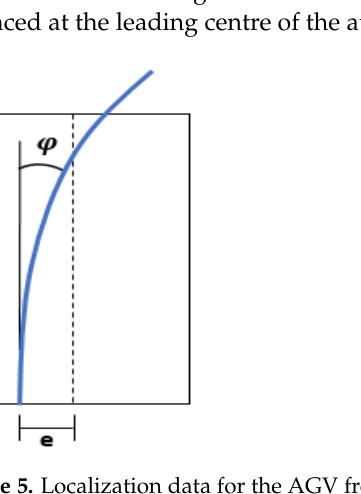
( b ) Figure 6. Path approach: ( a ) Situation where φ path is zero; ( b ) Situation where φ path is not zero. With this approach, it is possible to analyse the stability of the system and to get the K 1 and K 2 values. 4. Value of K 1 4.1. System Stability Study Lyapunov stability analysis is performed as mentioned above. Conventional tech- niques, for instance “frecuency” methods, are generally carried out on cases where the dynamical model of the system is linear. In the present study, the dynamical model is non- linear and the use of Lyapunov provides a generalist manner of assuring the stability of a dynamical system. The first scenario is where can be assumed that the angle of the trajectory is zero, as illustrated in Figure 6a. Considering that assumption, the terms A and C of the path equa- tion disappear, the path being By = 0. Hence, the study is simplified.